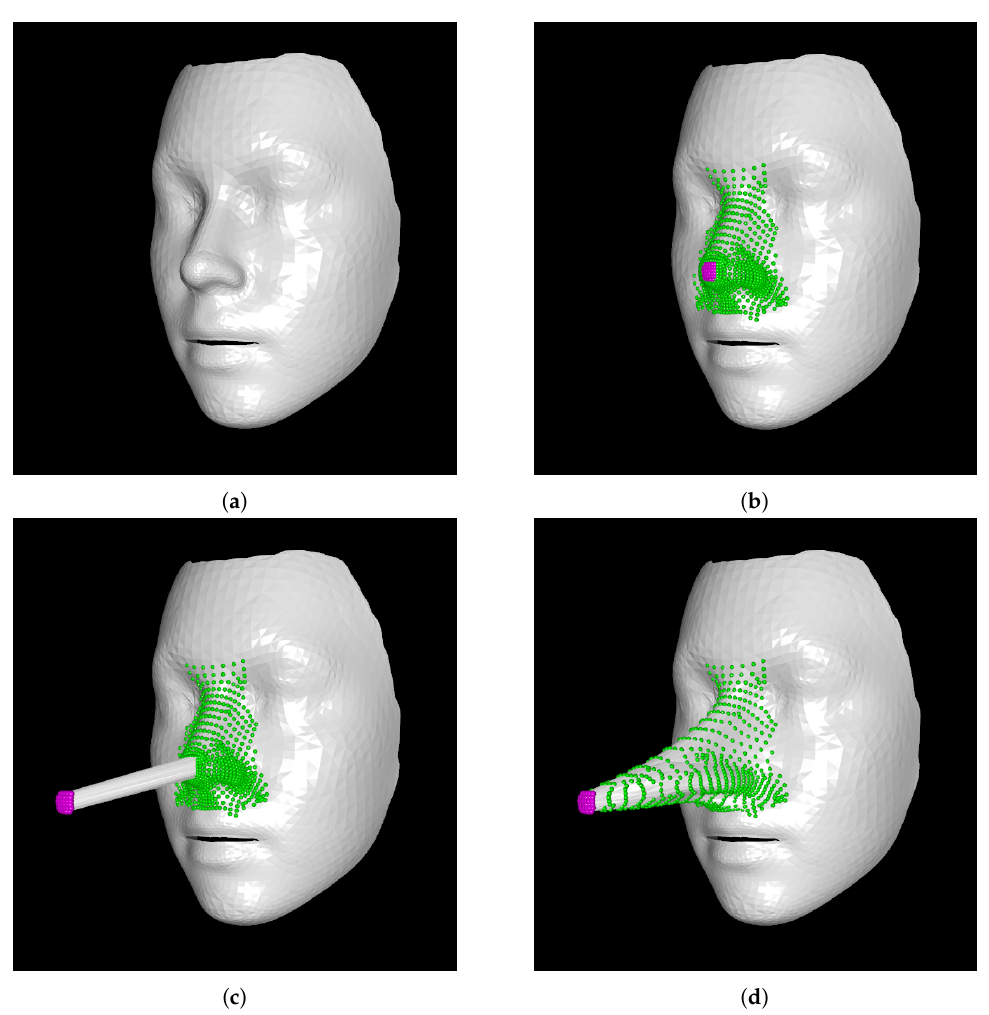
Figure 4. Results of mesh deformation by a user’s input: ( a ) original mesh model; ( b ) setting handle anchors (purple dots) and ROI anchors (green dots) as a user constraint; ( c ) moving handle anchors; and ( d ) deformed